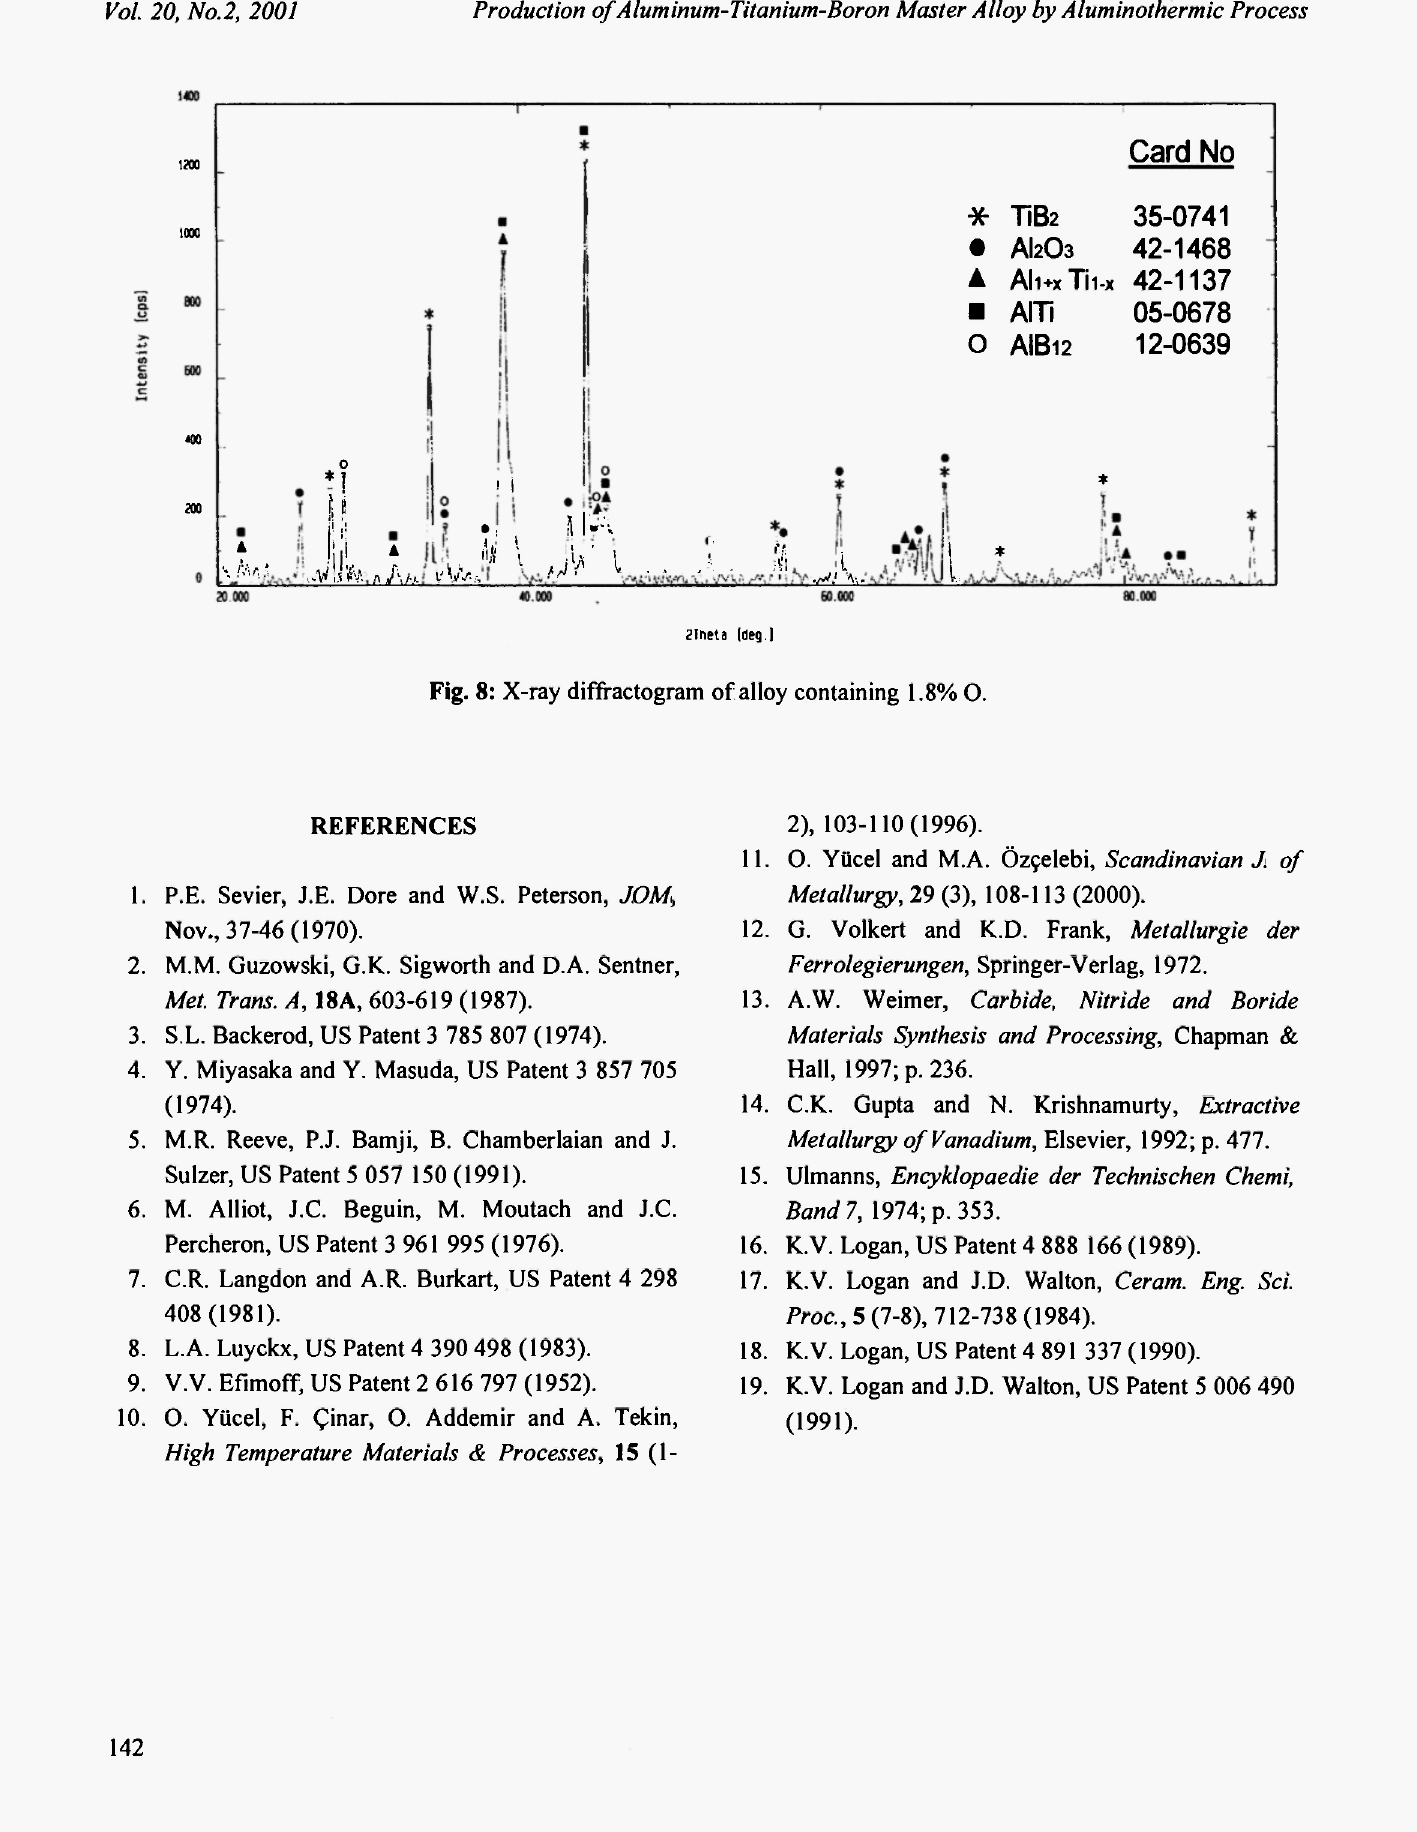
Fig. 8: X-ray diffractogram of alloy containing 1.8%